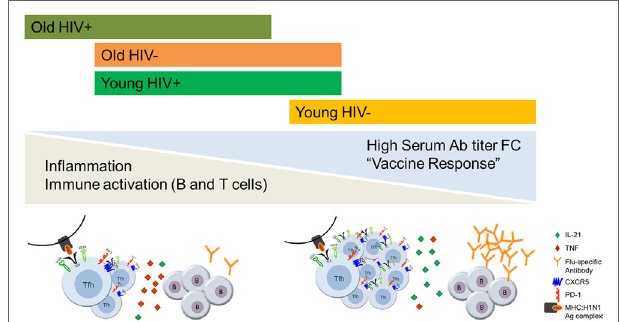
FiGURe 1 | The effects of aging and HIV infection on T follicular helper (Tfh):B cell responses to influenza vaccination. Persistent inflammation and immune activation of CD4 T cells and B cells negatively influence the outcome of influenza vaccine response in antiretroviral therapy (ART)-treated HIV-infected virologically suppressed individuals through impairing the Tfh and B cell functions. HIV induced premature Immunosenescence further advanced immune dysfunction which is more evident in the young HIV +